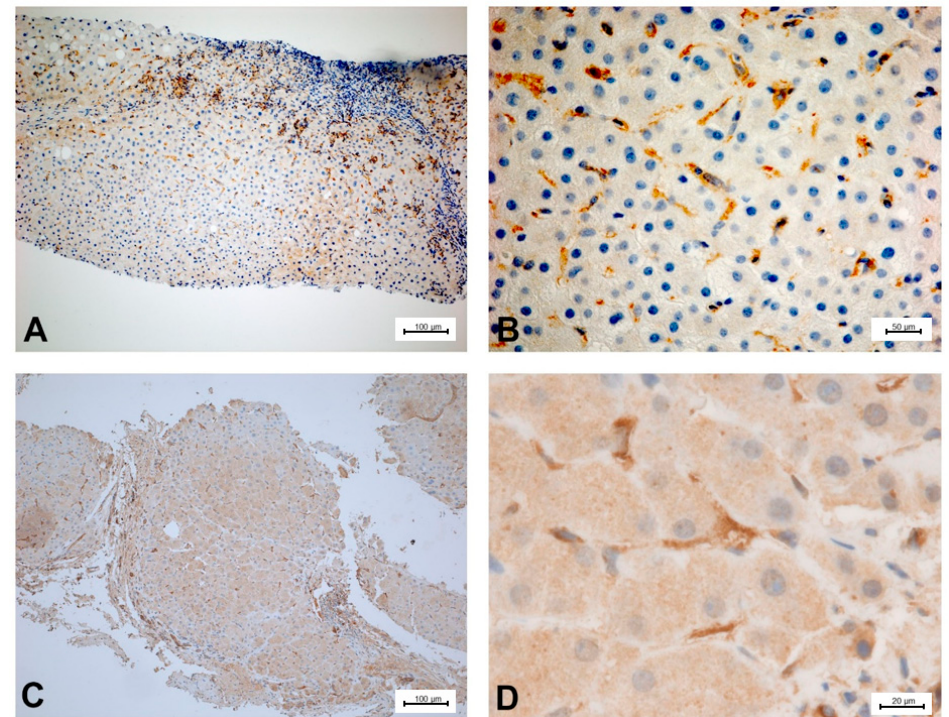
Figure 4. PDE-5 expression in healthy human liver tissue. Immunostaining for PDE-5 highlights portal tract vascular smooth muscle cells and myofibroblasts and shows reactivity of scattered sinusoidal lining cells in zone 1 and 2 ( A ). PDE-5 expression is enhanced in the cytoplasm of hepatocytes adjacent to terminal hepatic venules ( B ) and in zone 3 sinusoidal lining cells ( C , D ).